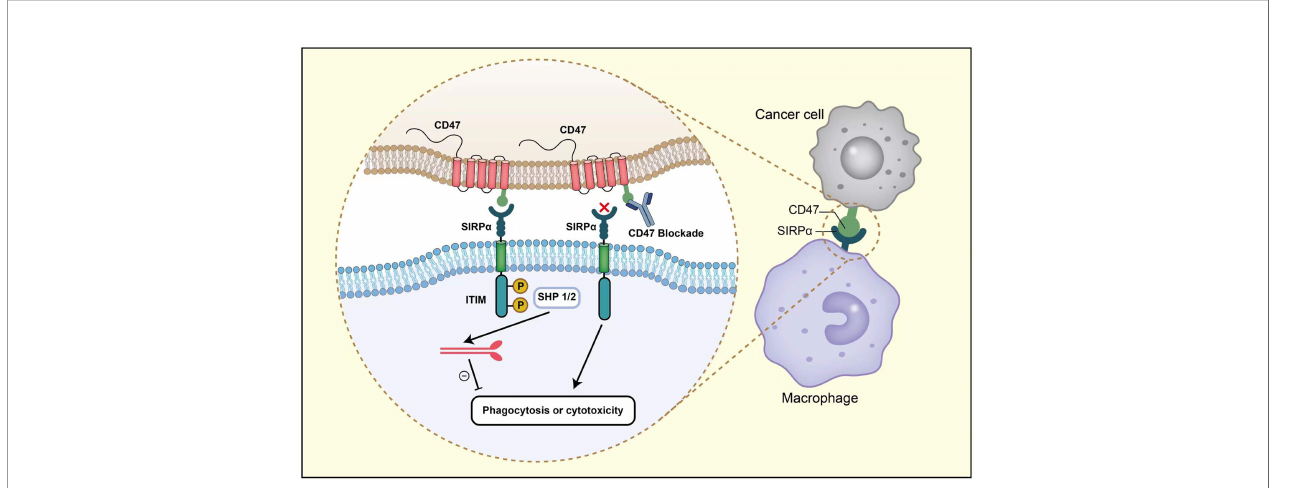
FIGURE 1 | After the interaction between CD47 and SIRP a , two tyrosine residues from ITIM in the intracellular domain of SIRP a become phosphorylated. The phosphorylation activates SHP1 and SHP2, leading to the dephosphorylation of myosin IIA, thereby preventing macrophage phagocytosis. Anti-CD47 antibodies could block CD47-SIRP a axis and promote